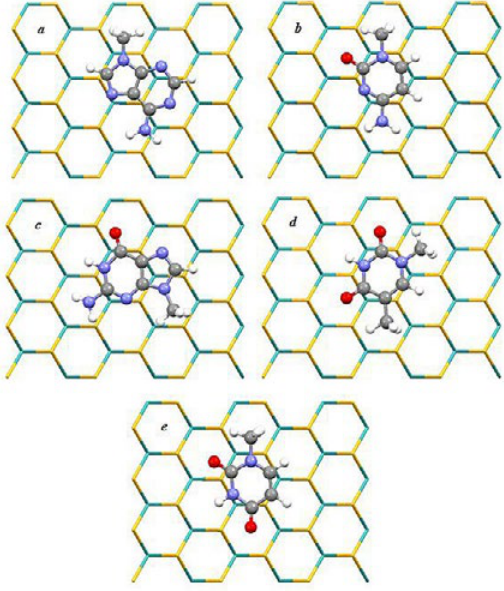
Fig. 1. Optimized structures of nucleobases adsorbed onto monolayer MoS .[( a ) Adenine, ( b ) Cytosine, ( c ) Guanine, ( d ) 2 Thymine and ( e ) Uracil]. (Purple: Mo, Yellow: S, Red: O, Blue: N, Gray: C and White: H).